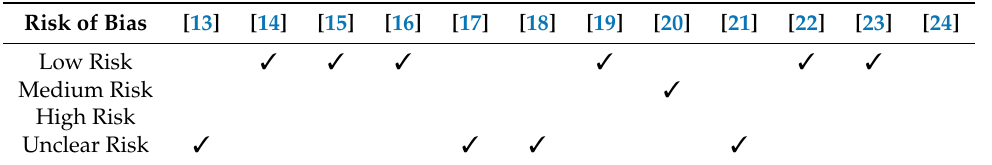
Table 2. Risk of bias